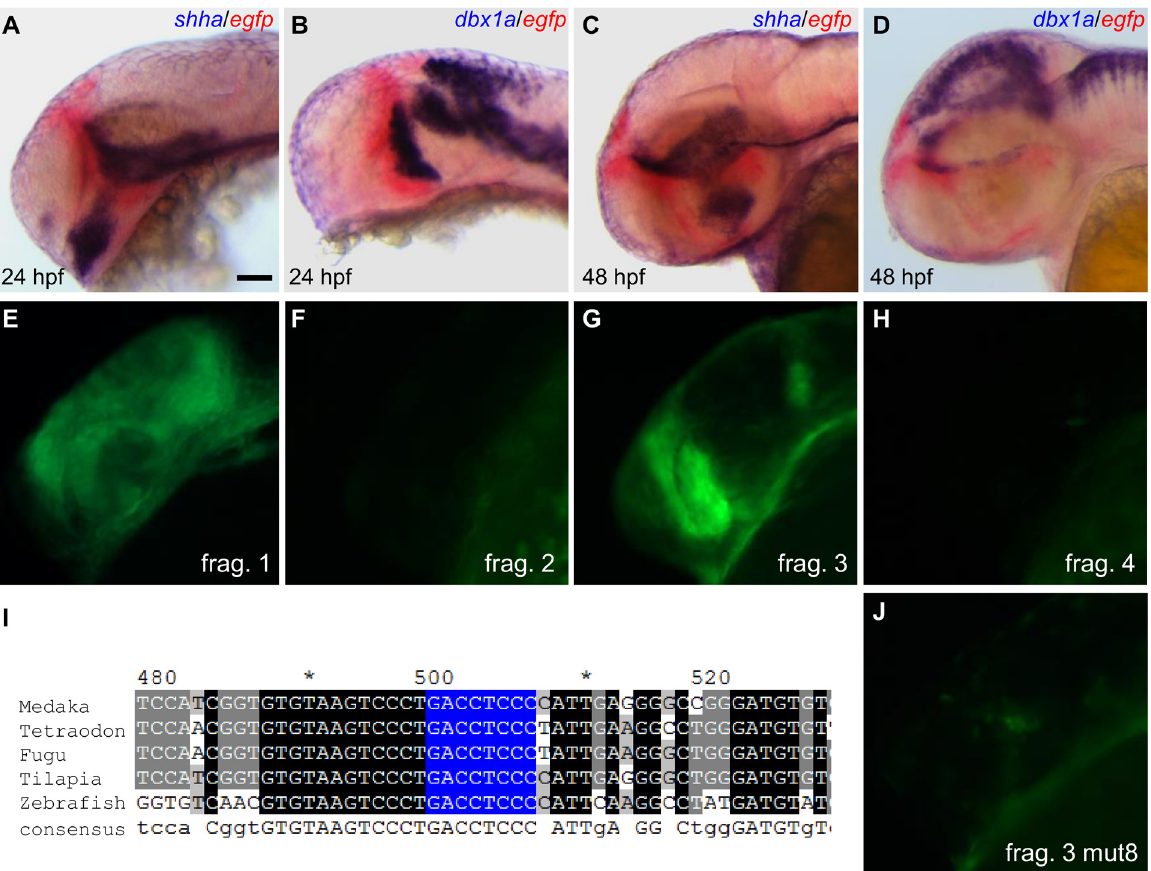
Fig 4. CNS4 contains pre-thalamic enhancer activity and relies on a zic binding site. (A-D) Double in situ hybridization results indicate CNS4 contains pre-thalamic enhancer activity. ZLI (zona limitans intrathalamica) marker shha and thalamic marker dbx1a are stained in dark blue, reporter egfp stained in red. CNS4 driven EGFP expression abuts anteriorly to the ZLI and thalamus in the 24hpf (A-B) and 48hpf (C-D) stage embryos. ( E-H ) The third fragment of the four subdivisions of the CNS4 sequence contains pre-thalamic enhancer activity. ( I ) Multiple sequence alignments of the CNS4 region in the five teleost species. The identified zic binding site is highlighted in blue. ( J ) Mutation of the 8bp zic binding site in the prethalamic enhancer abolished its activity. Lateral view of the forebrain regions of embryos at 24 hpf (A-B, E-H, and J) or 48 hpf (C-D), anterior to the left. Scale bar: 50 μ m.